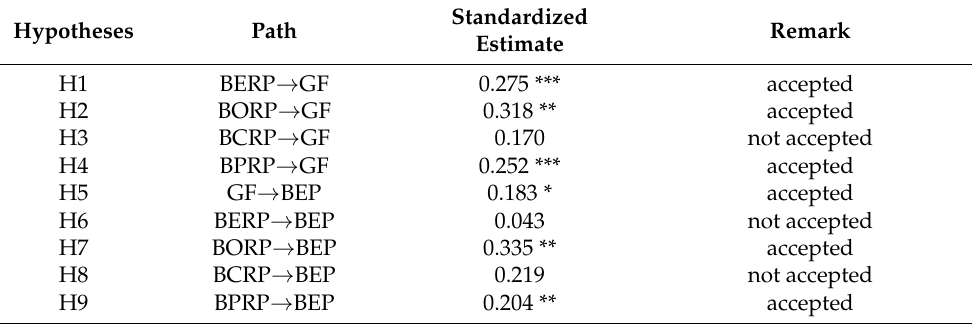
Table 9. Test of Research